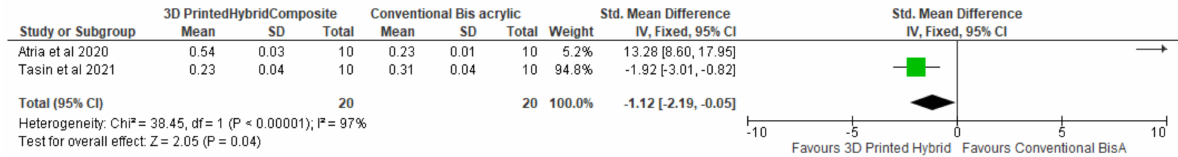
Figure 11. Forest plot comparing surface roughness between 3D-hybrid composite resin and conven- tional bBis-acrylic resin.